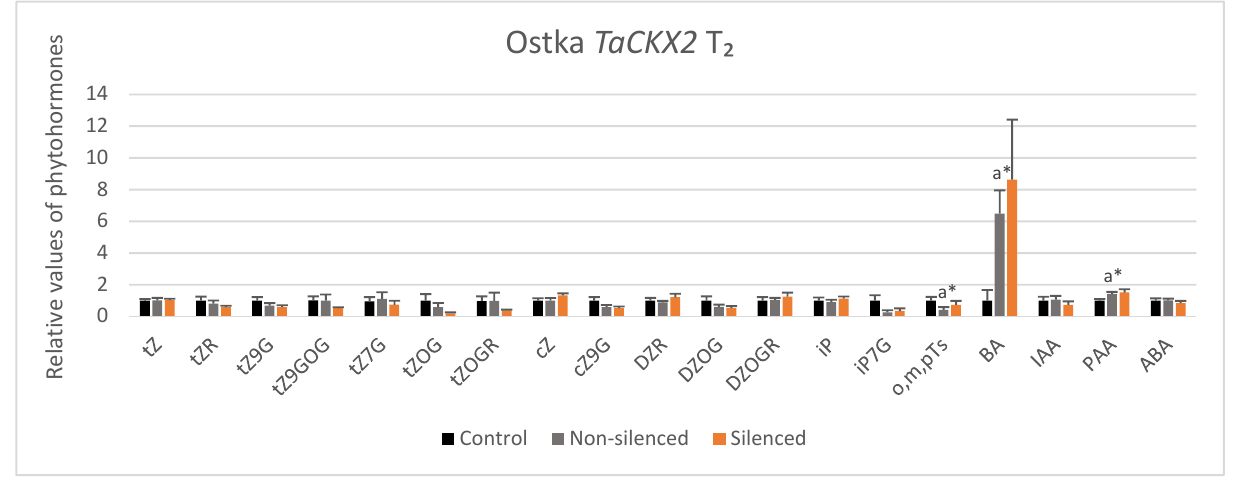
Figure 4. Phytohormone content ( A ) and their relative values ( B ) in control (black bars), nonsilenced (grey bars) and silenced (orange bars) TaCKX2 , T 2 lines. Trace amounts (<0.1 ng/g biomass): tZ7G, cZR, iPR, oT. Not detected: cZOG, cZOGR, DZ, DZ9G, DZ7G, IPA, IBA, GA. Error bars denote ± SE. Significant differences between control and nonsilenced or silenced lines (a): * significant at p ≤ 0.05; ** significant at p ≤ 0.01.